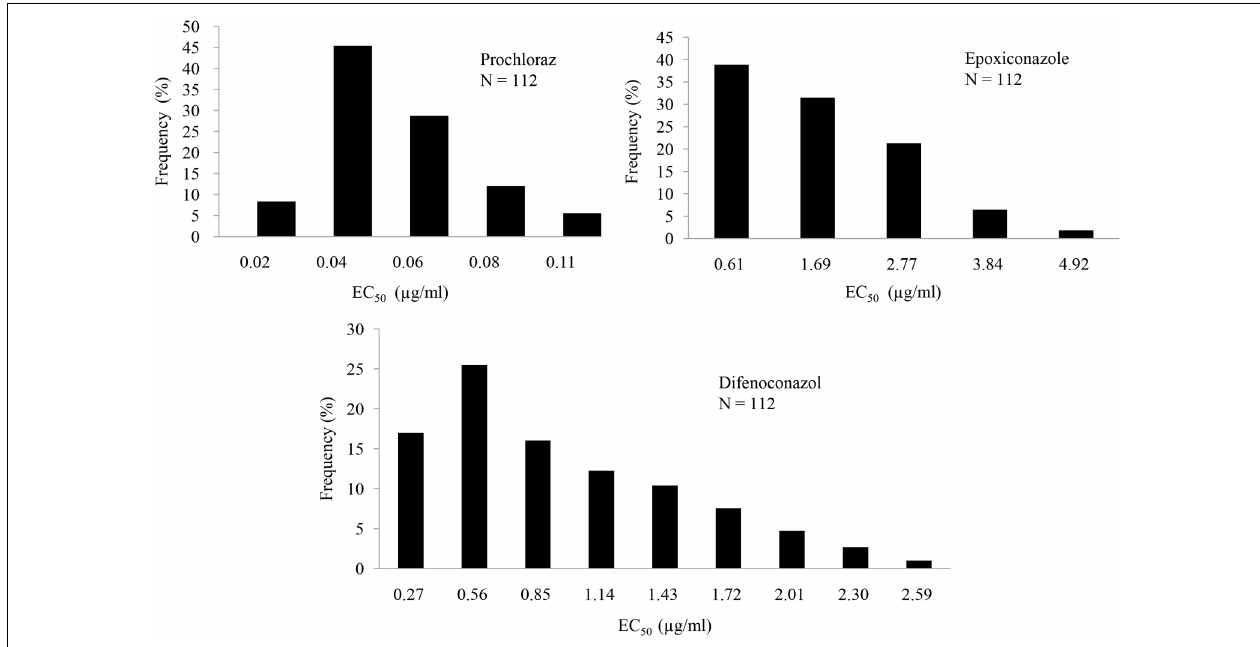
FIGURE 1 | Frequency distributions of effective concentrations for 50% growth inhibition (EC 50 ) of prochloraz, epoxiconazole, and difenoconazole against 112 Colletotrichum truncatum isolates.